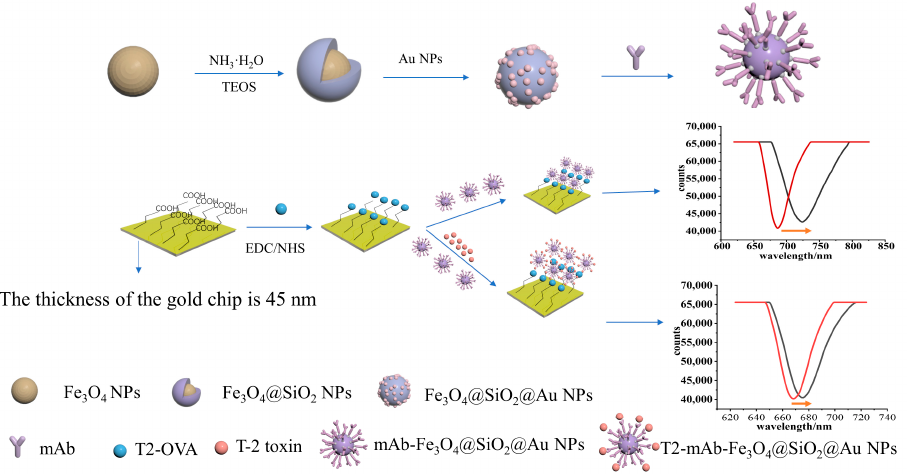
Figure 1. A flow chart of synthesis process of Fe 3 O 4 @SiO 2 @AuNPs and a schematic diagram of T-2 toxin detection